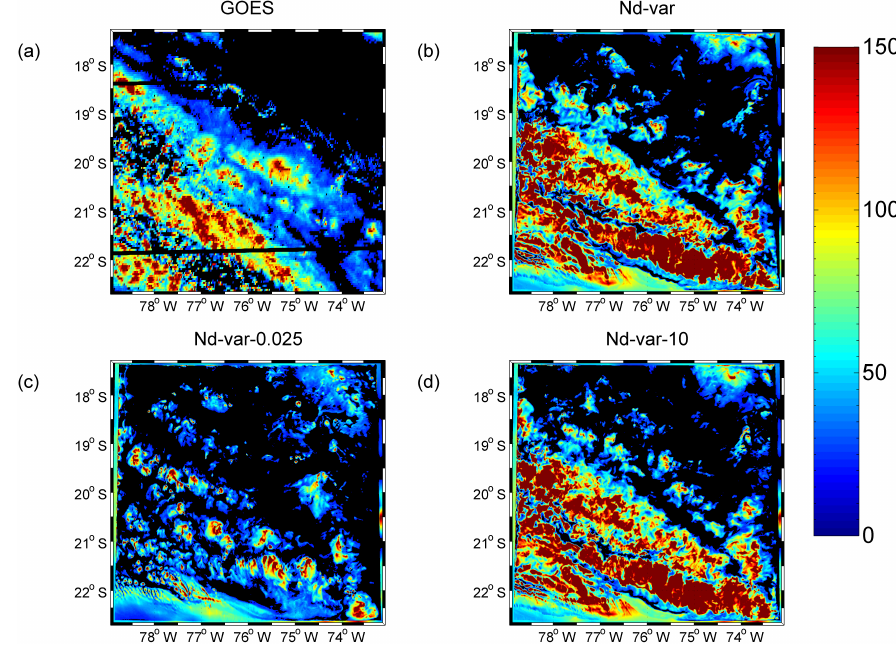
Figure 6. Daytime snapshots of LWP (gm − 2 ) for 13 November 2008 for the region of the inner model domain. (a) GOES-10 satellite at 13:57LST (daytime); (b) model with control aerosol; (c) model with × 0.025 aerosol; (d) model with × 10 aerosol. The model images are from 14:12LST. Regions where the LWP is less than 20gm − 2 are plotted as black to give an estimate of cloud